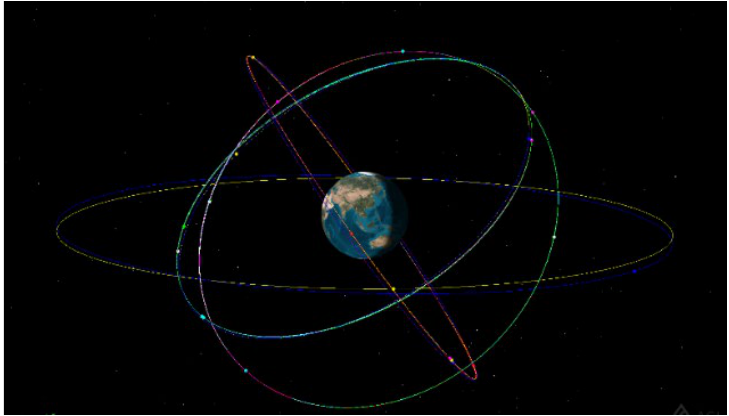
Figure 11. The simulation experiment scene of BEIDOU-3 satellite. We created some BEIDOU-3 satellite and they run in orbit.